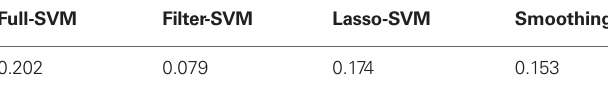
Table 3 | estimated misclassification rates by a 10-fold